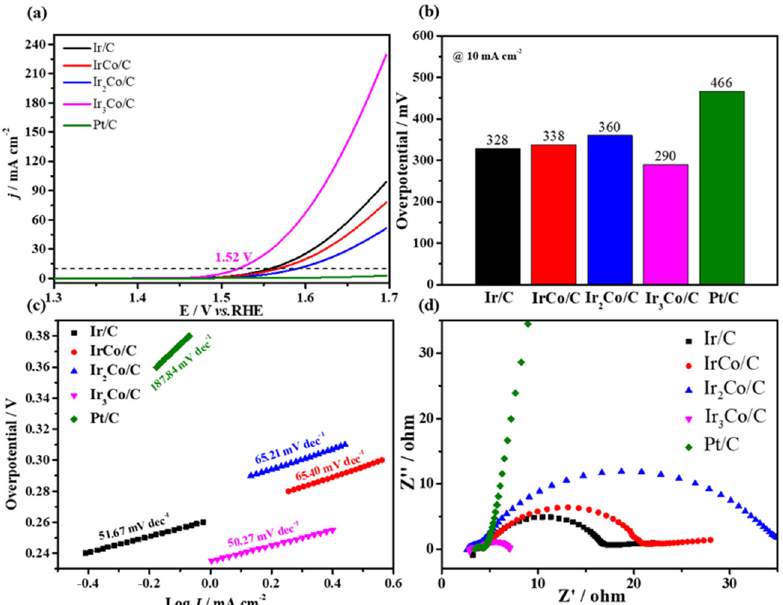
In the original publication, there was a mistake in the legend for Figure 2. Electrochemical test results of different catalysts. (a) Polarization curves of OER in 0.5 M H 2 SO 4 . (b) The overpotential required to reach 10 mA cm − 2 . (c) The corresponding Tafel slopes. (d) EIS and Figure 3. Electrochemical test results of different catalysts. (a) Polarization curves of HER in 0.5 M H 2 SO 4 . (b) The overpotential required to reach 100 mA cm − 2 . (c) EIS. (d) Electrical double-layer capacitor (C dl ). Due to the process of unifying the unit format of the graph, the picture is not properly labeled, and the picture is misplaced. The correct legend appears below. The authors state that the scientific conclusions are unaffected. This correction was approved by the Academic Editor. The original publication has also been updated.